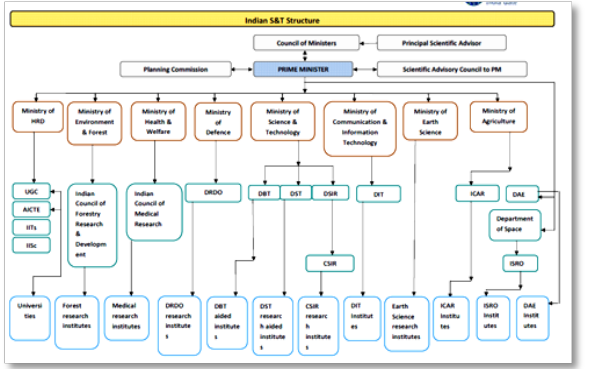
Figure 3: Indian S & T Structure; (Source: IndiaGate, European Commission, image)